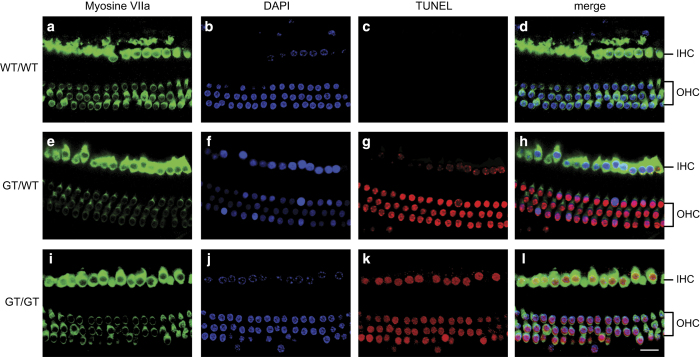
Detection of apoptosis by TUNEL assay in control and mutant cochlea. (a, e, i) Wild-type and mutant organ of Corti immunostained for Myosine VIIa (green) to detect hair cells. (b, f, j) DAPI (blue) and (c, g, k) TUNEL (red) staining observed in the organ of Corti in basal turn for 14-3-3etaWT/WT, 14-3-3etaGT/WT and 14-3-3etaGT/GT. (c) No TUNEL-positive cells were detected in the control cochlea. (g, k) Positive TUNEL staining was seen in both 14-3-3etaGT/WT and 14-3-3etaGT/GT. (d, h, l) Merge images with Myosine VIIa (green), DAPI (blue) and TUNEL (red). Scale bar=20 μm.